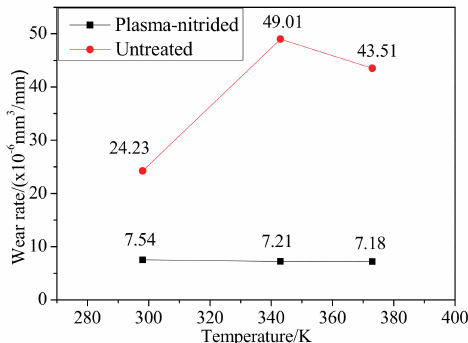
Figure 17. The wear rates of untreated specimens and plasma-nitrided specimens under di ff erent friction temperatures at 100 N / 16.7 mm · s − 1